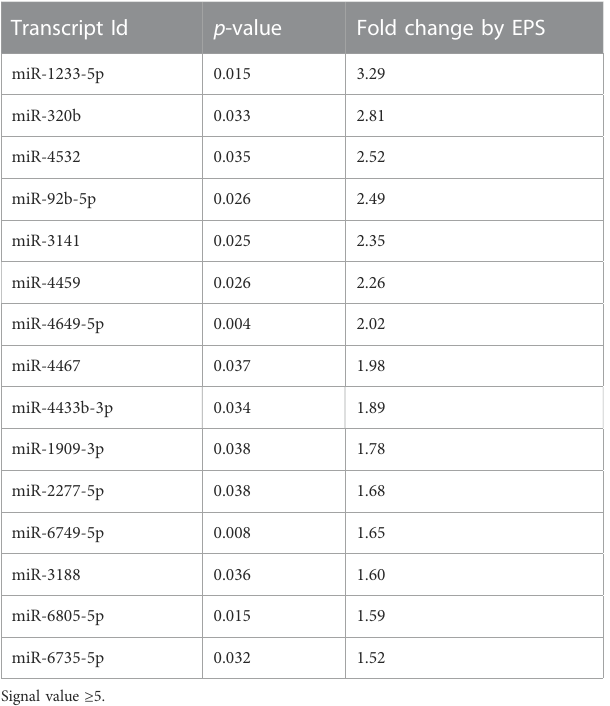
TABLE 1 Exosome miRs signi fi cantly changed by EPS.